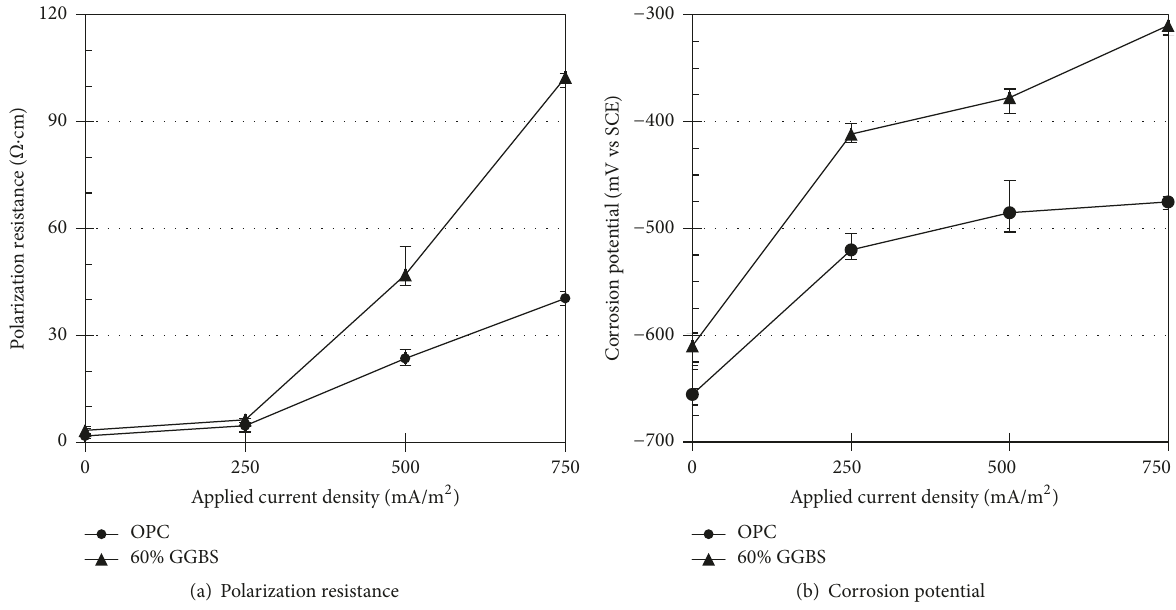
Figure 3: Polarization resistance (a) and corrosion potential (b) in different concrete mix after electrochemical treatment at 250, 500, and 750 mA/m 2 for 4